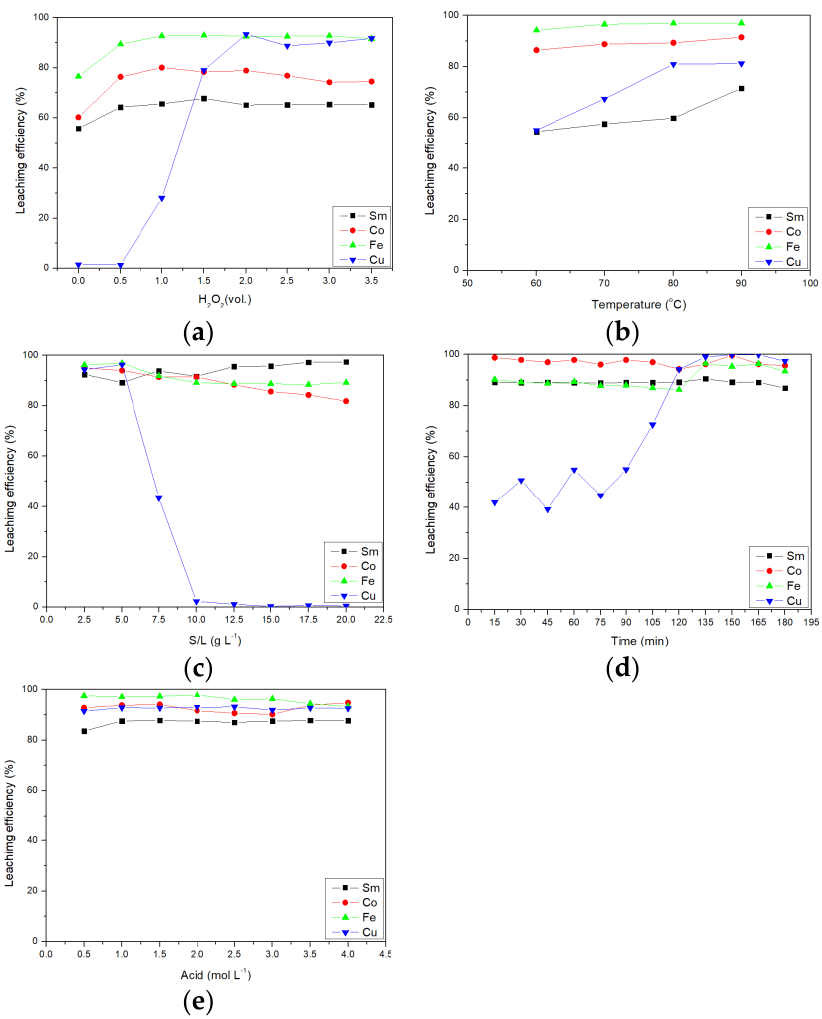
Figure 2. Effect of ( a ) amount of H 2 O 2 , ( b ) temperature, ( c ) S/L ratio, ( d ) time, and ( e ) acid concentration on the leaching efficiency of citric acid.